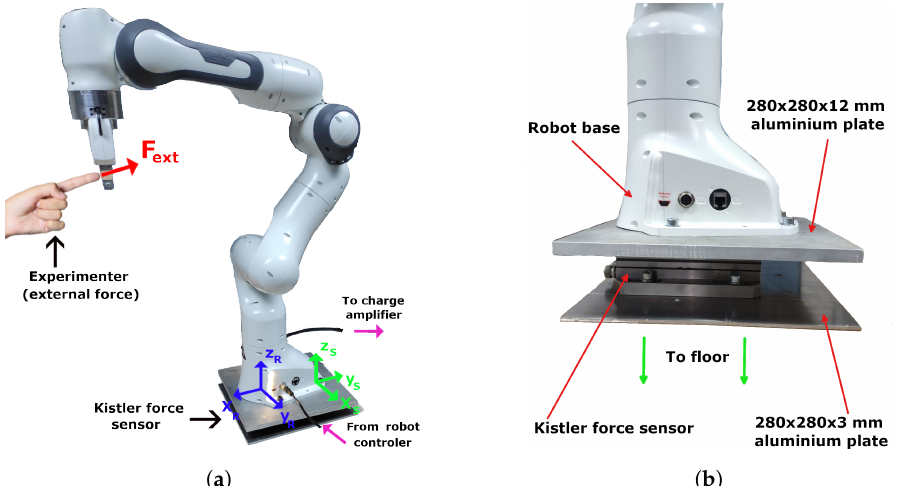
Figure 4. Real-world experimental setup: ( a ) Franka robot during measurements with installed sensor under the base; ( b ) interconnection between the robot base, force sensor, and the environment.